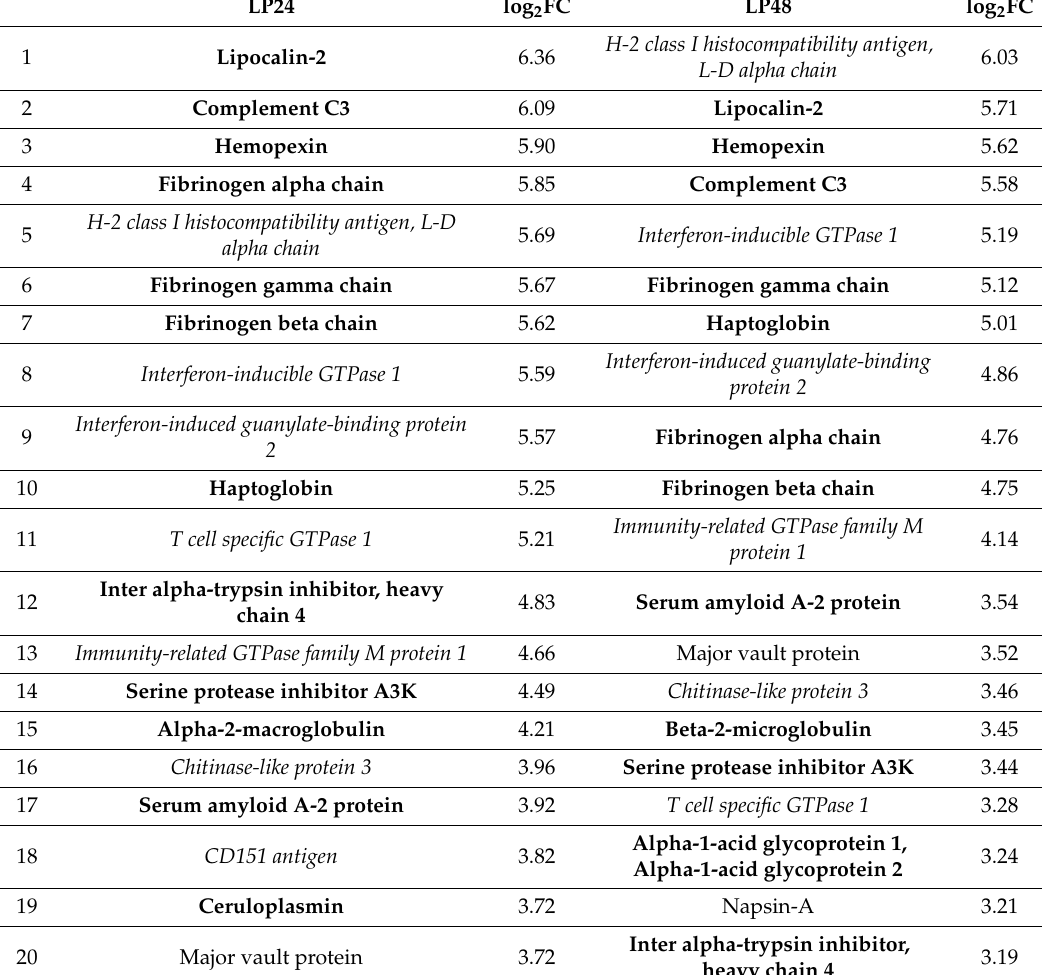
Table 2. List of top 20 proteins significantly upregulated at least 4-fold (log 2 FC = 2) relative to the controls kidneys at LP in mice. APPs are highlighted in bold, other proteins involved in response to stress are highlighted in italics, proteins present at both time points are highlighted in grey. log 2 FC: log2 transformed values of fold